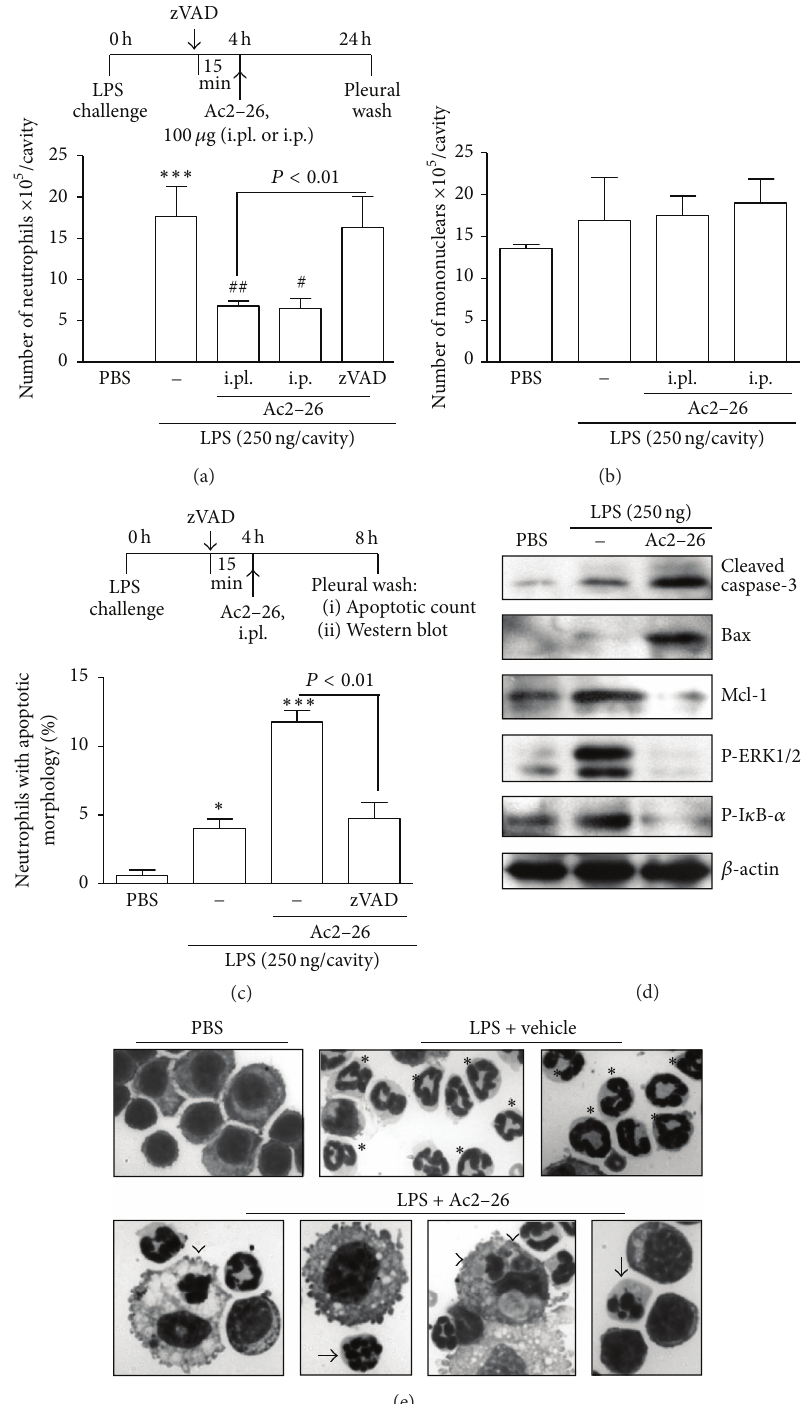
Figure 2: Effect of exogenous administration of AnxA1 derived peptide Ac2–26 on LPS-induced pleurisy. Mice were injected with LPS (250 ng/cavity, i.pl.) and 4 h later received an injection of Ac2–26 (100 𝜇 g/mouse, i.pl. or i.p.). The treatment with the pan-caspase inhibitor zVAD-fmk (1mg/kg, i.p.) was performed 15min before the injection of peptide. The numbers of neutrophils (a) and mononuclear cells (b) were evaluated 20 h after drug treatment. Cells with distinctive apoptotic morphology (c and e) and Western blot for detection of cleaved caspase-3, Bax, Mcl-1, P-ERK, and P-I 𝜅 B- 𝛼 (d) were evaluated 4 h after the peptide treatment. ∗ 𝑃 < 0.05 or ∗∗∗ 𝑃 < 0.001 when compared with PBS-injected mice and # 𝑃 < 0.05 or ## 𝑃 < 0.01 when compared with vehicle-treated, LPS-injected mice. (e) Representative figures of nonapoptotic (asterisk) and apoptotic (arrows) neutrophils and apoptotic cells inside macrophages (arrowheads). PBS and vehicle (upper panels) and Ac2–26-treated (lower panels) animals are shown. Original data from Vago et al., 2012